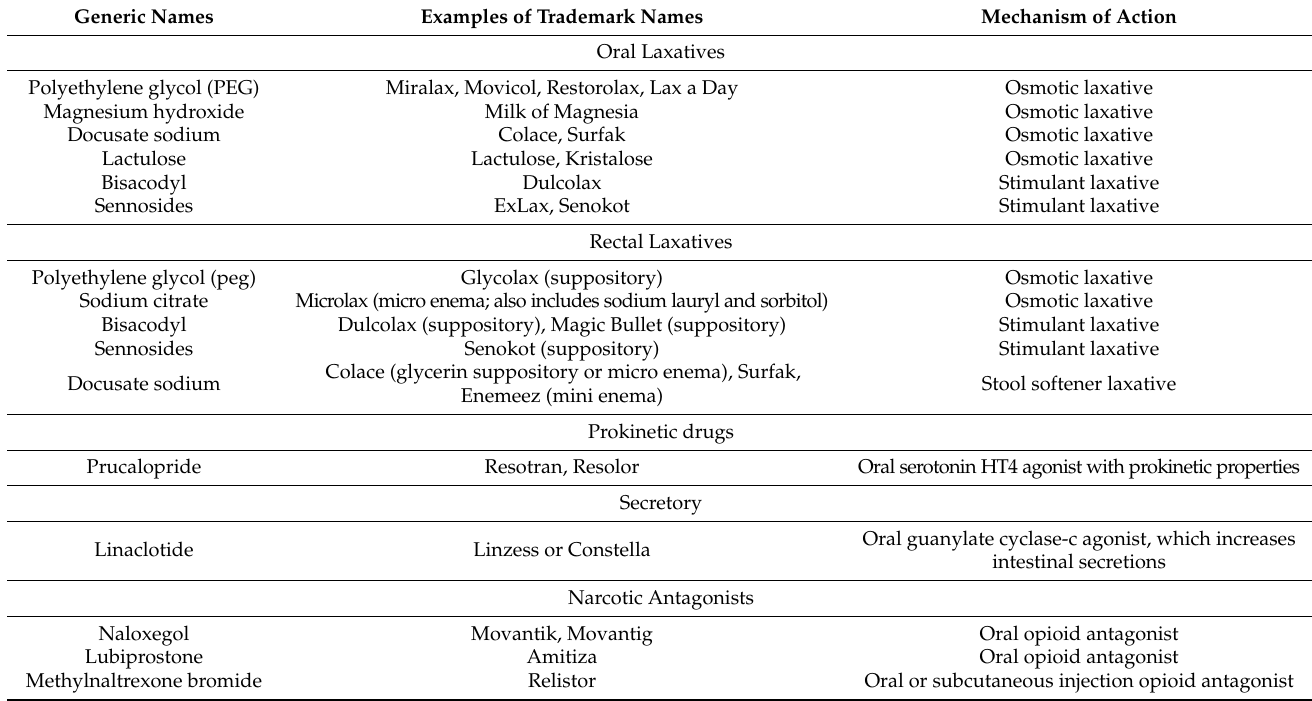
Table 1. Current Medications used in neurogenic bowel dysfunction (NBD), including mechanism of